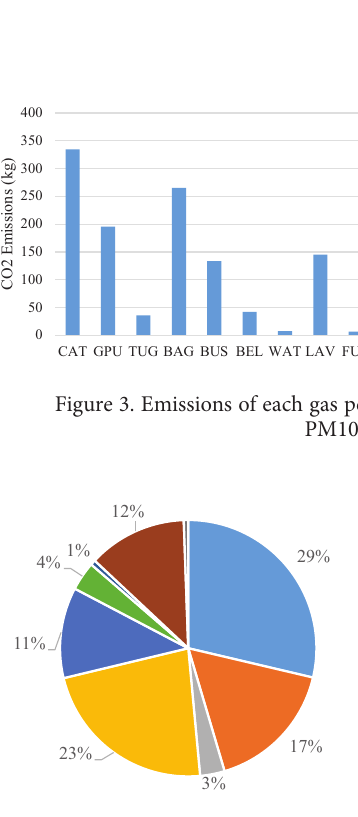
Figure 4. Emission distribution per GSE: a – CO 2 analysis; b – CO